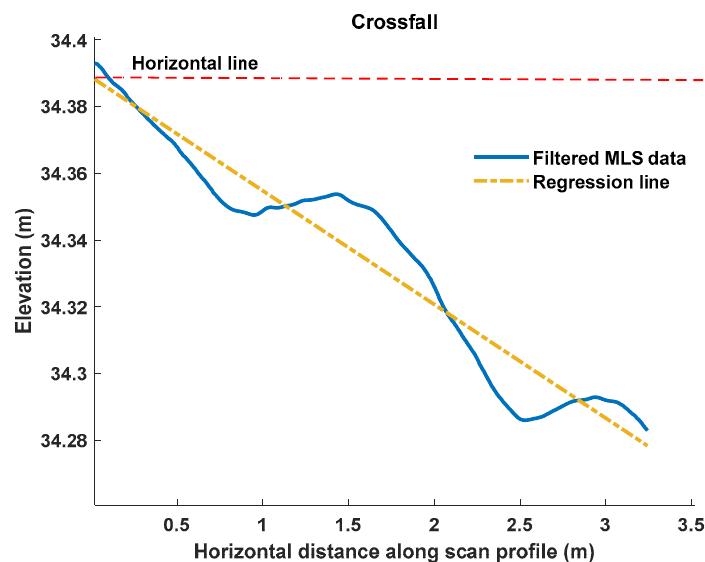
Figure 16. Crossfall estimation for one scan profile in MLS data.